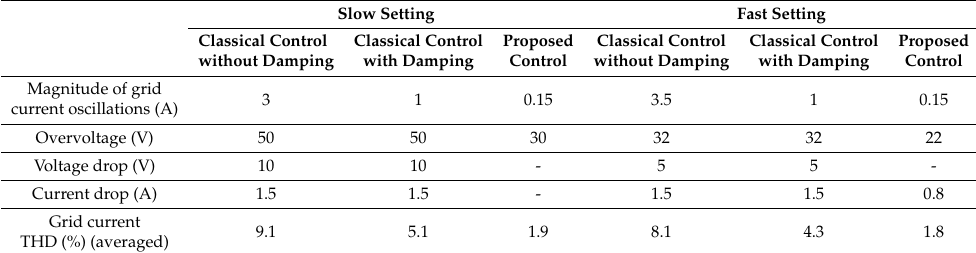
Table 5. Simulation results of the different methods regarding the magnitude of oscillations in steady-state and dynamic performances during a load step from 10 Ω to 20 Ω .